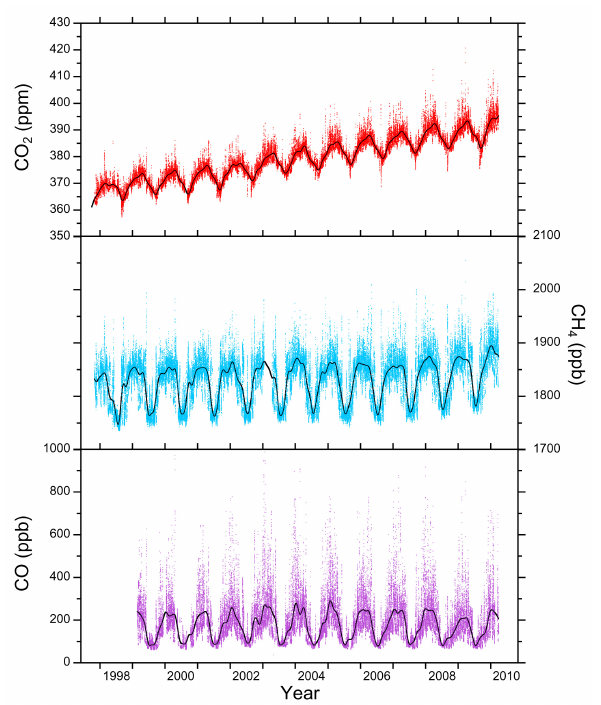
Fig. 2. Time series of atmospheric (top) CO 2 , (middle) CH 4 , and (bottom) CO mixing ratios observed at HAT. Each dot represents hourly average. Black lines represent the smooth curve fits to the data.